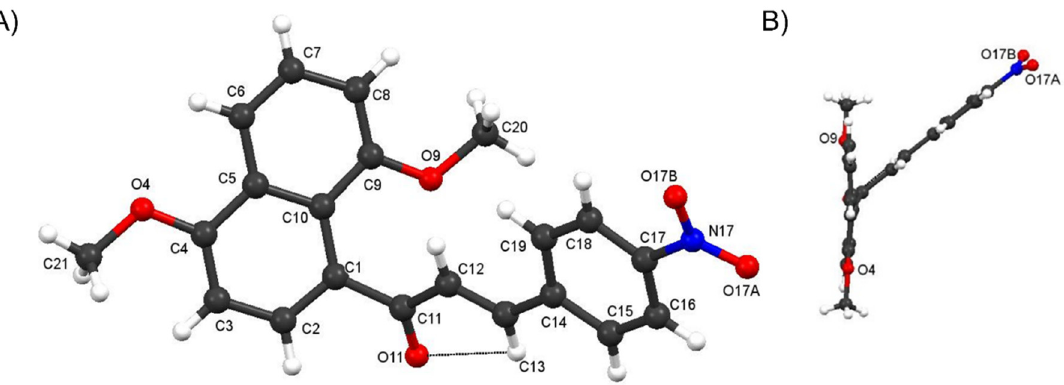
Figure 3. ( A ) The atom arrangement and numbering scheme for compound 4f . ( B ) Interplanar angle between the naphthalene and phenyl rings of compound 4f .